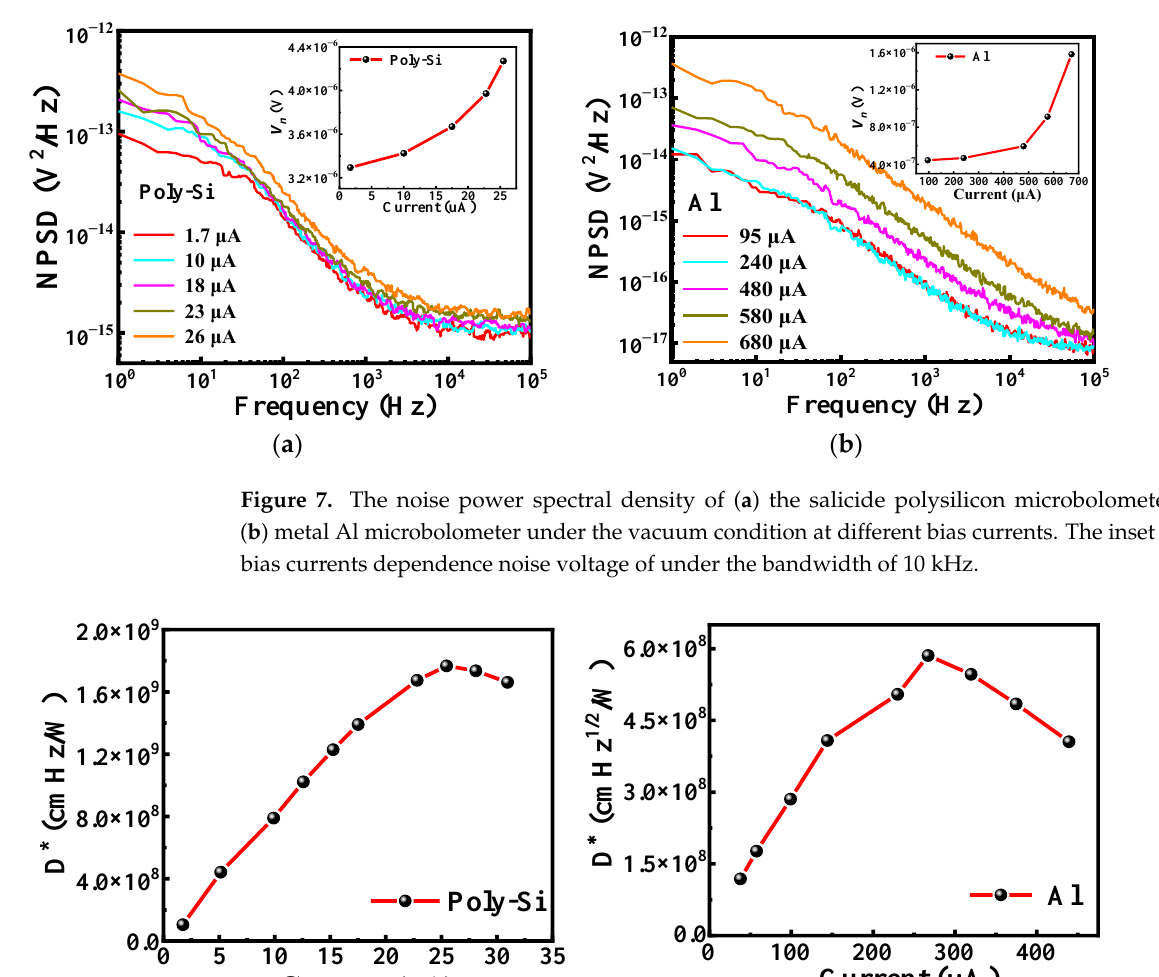
Figure 7. The noise power spectral density of ( a ) the salicide polysilicon microbolometer and ( b ) metal Al microbolometer under the vacuum condition at different bias currents. The inset shows bias currents dependence noise voltage of under the bandwidth of 10 kHz.